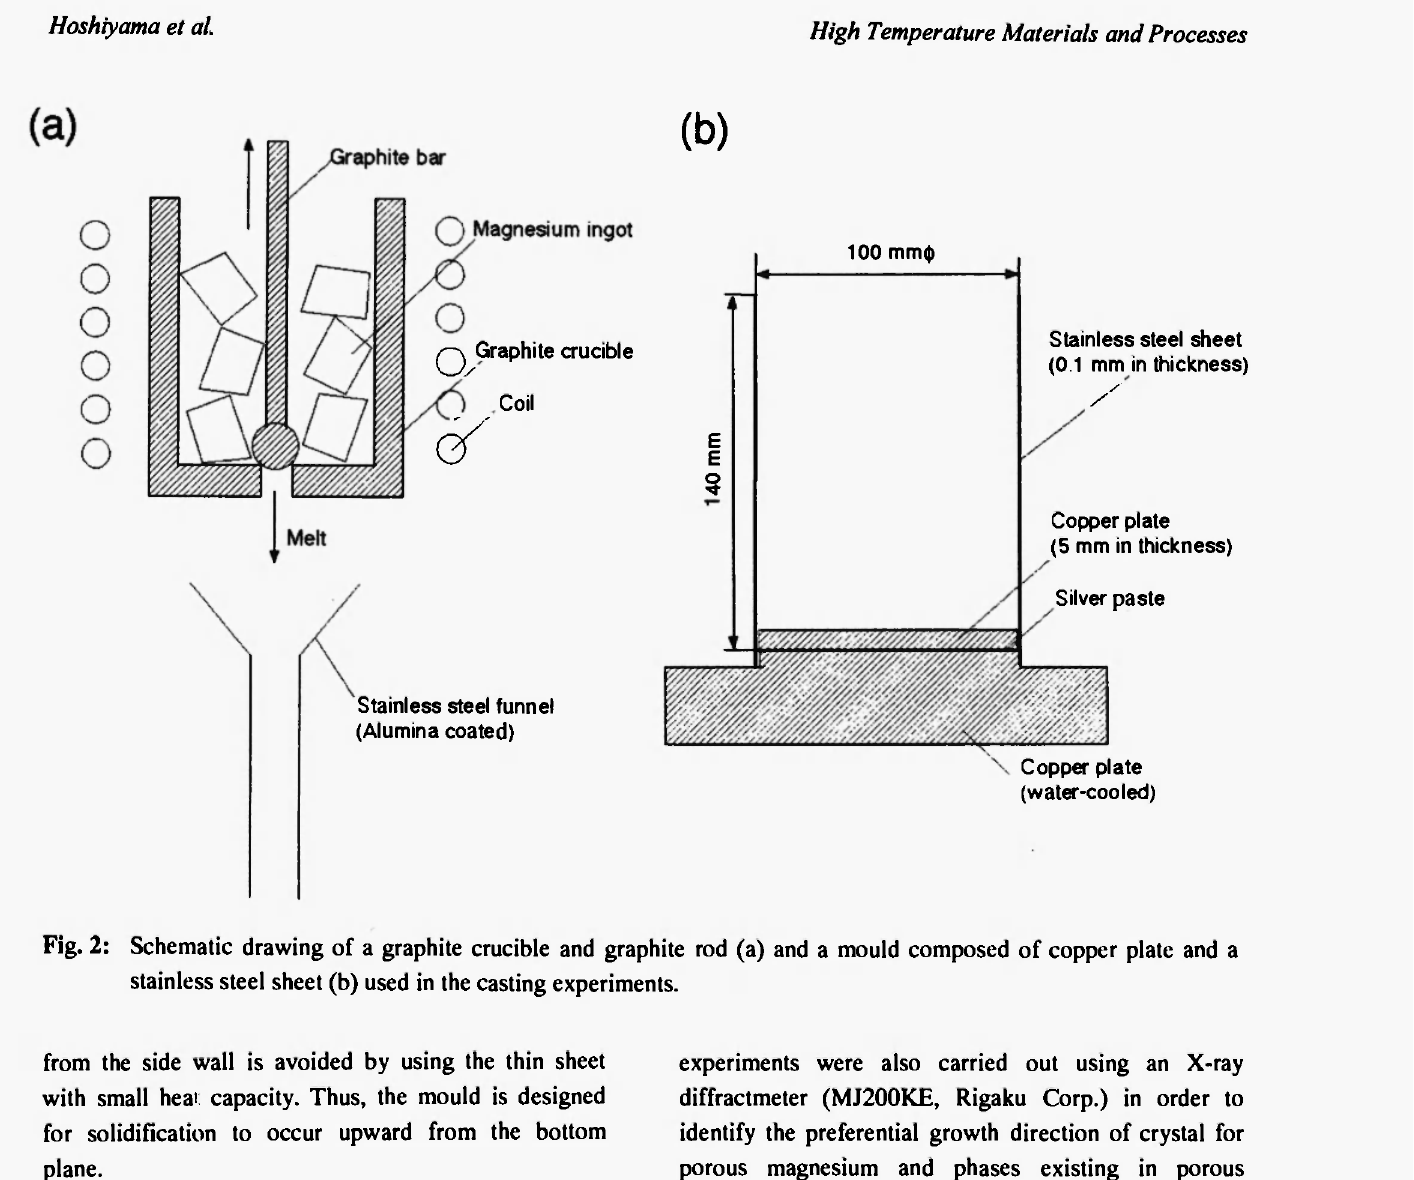
from the side wall is avoided by using the thin sheet with small heat capacity. Thus, the mould is designed for solidification to occur upward from the bottom